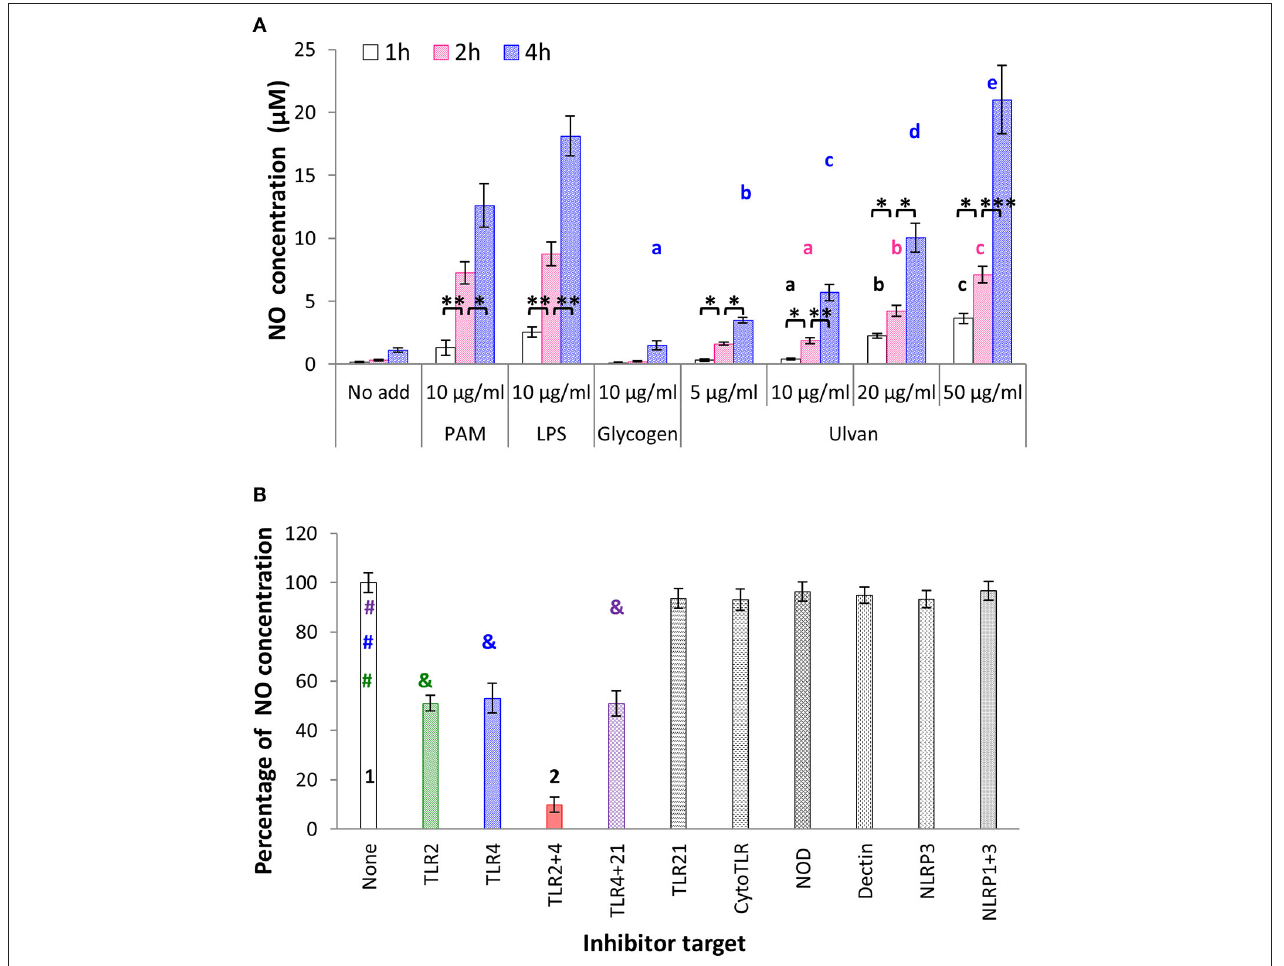
FIGURE 3 | (A) Ulvan causes NO release by monocytes. Ulvan triggers NO release in a dose- and time dependent manner, measured using Griess’ reagent. Data represents the mean ± SEM of four independent experiments in duplicate. Letters indicate statistically different values for the different doses at the same time with p < 0.05. * p < 0.05, ** p < 0.01, *** p < 0.005 when values are statistically different for the same dose at different times. (B) Ulvan acts through TLR2- and TLR4-dependent mechanisms. Monocytes were incubated in vitro with different concentrations of ulvan, PAM as TLR2 agonist, LPS as TLR4 agonist, and